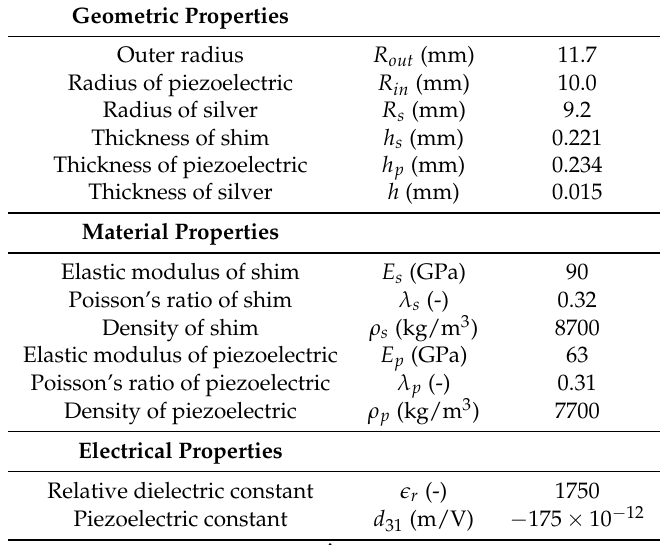
Figure 8. Problem setup and computational domain of the composite piezoelectric actuator. Note that the computational domain is taken as a quarter of the disc with symmetric planes. Table 5. Dimensions and material properties of the APC 850 actuator extracted from